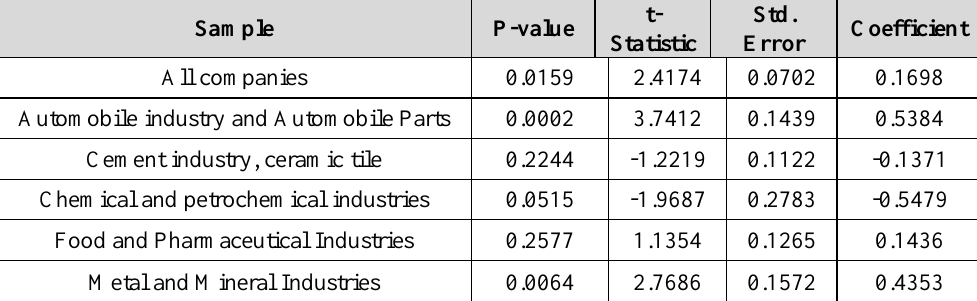
Table 7. Results of the Maturity stage and capital investment choice in the type of